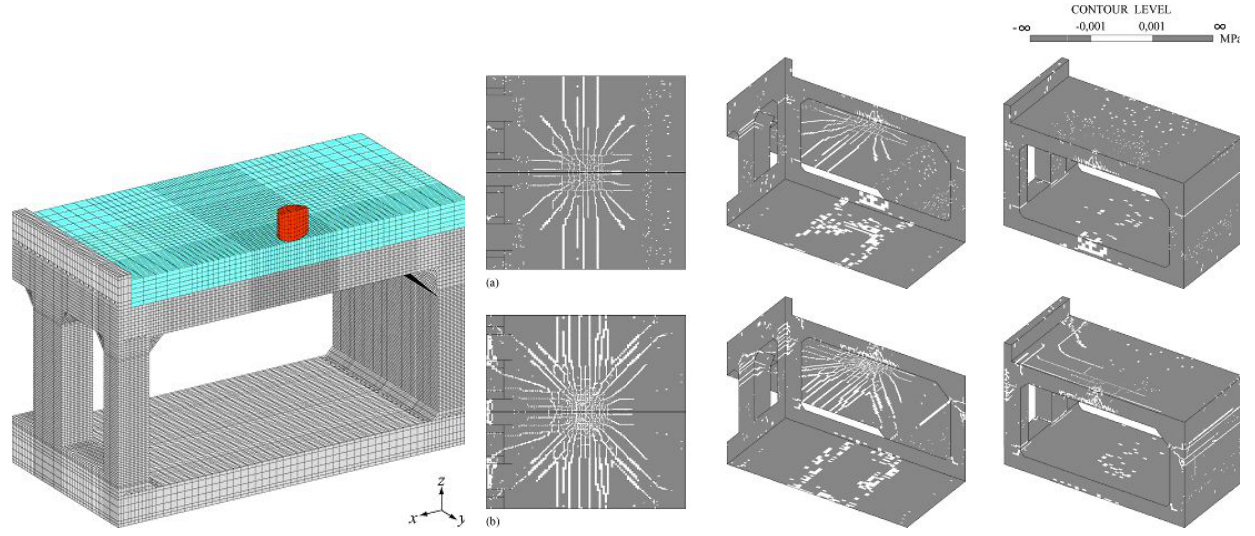
Fig. 17. General view of an FE analysis model of an impacted rock shed and the resulting crack patterns for different loading cases (from Kishi et al., 2009).